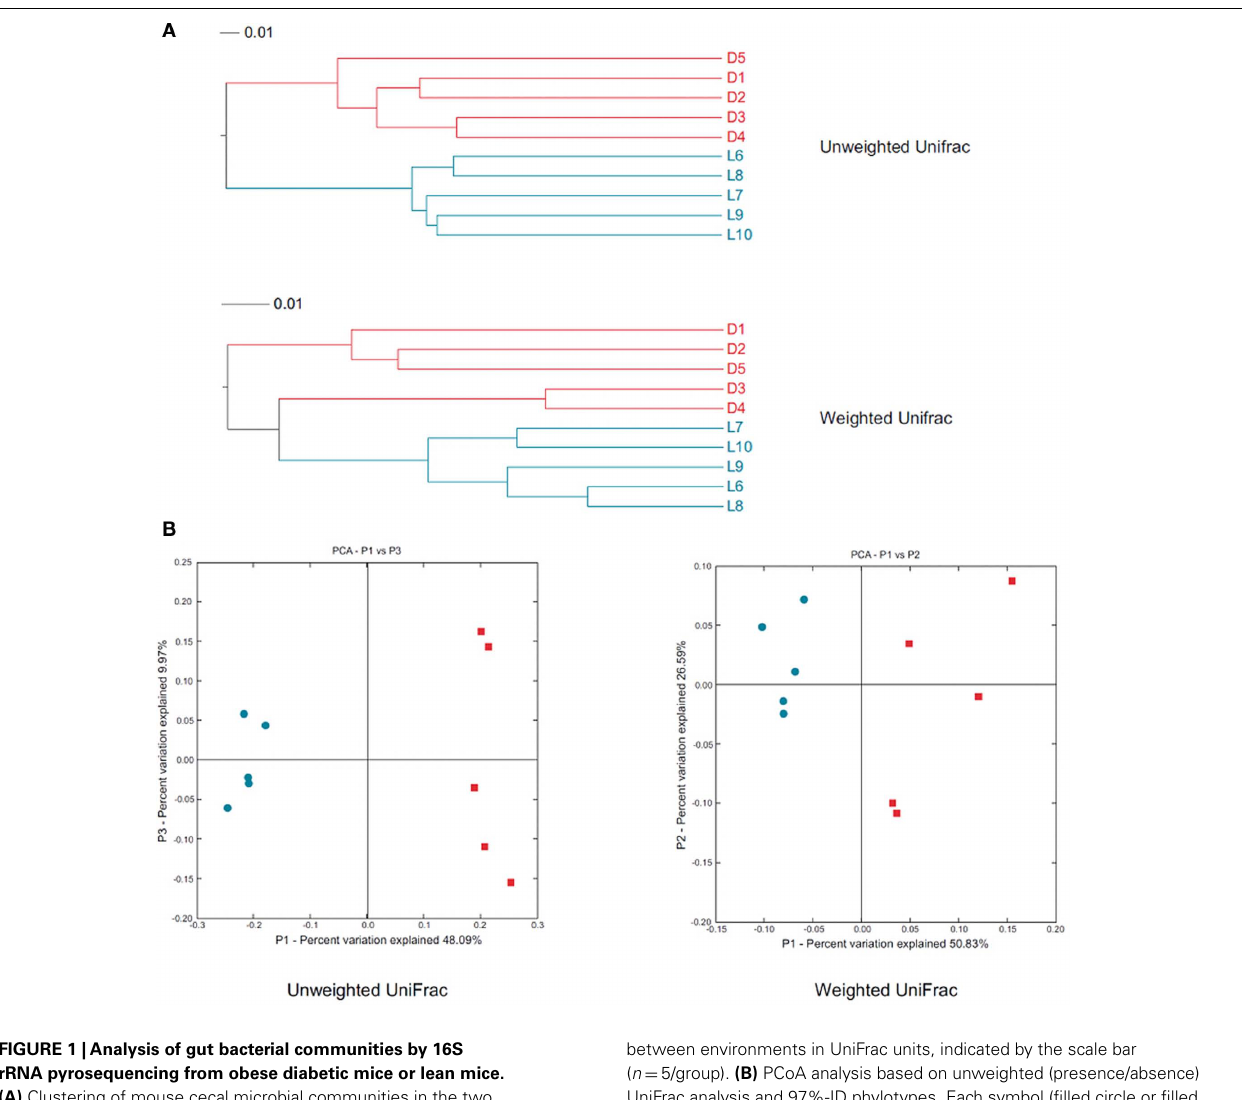
FIGURE 1 |Analysis of gut bacterial communities by 16S rRNA pyrosequencing from obese diabetic mice or lean mice. (A) Clustering of mouse cecal microbial communities in the two tested groups based on unweighted UniFrac analysis and 97%-ID phylotypes. Red indicates the diabetic mice ( db / db ), and blue indicates the lean mice. Branch length represents the distance